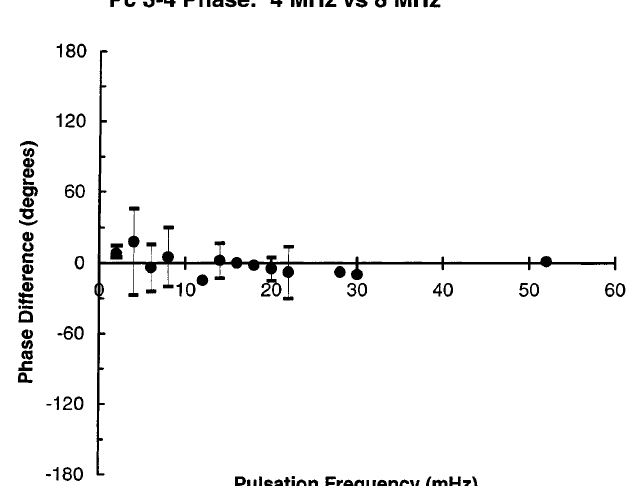
Fig. 6. Phase di(cid:128)erence between 4 and 8 MHz Doppler shift oscillations as a function of pulsation frequency for Pc 3-4 events . Error bars denote the mean and range of several observations. Positive phase indicates the 4 MHz Doppler oscillation leading the 8